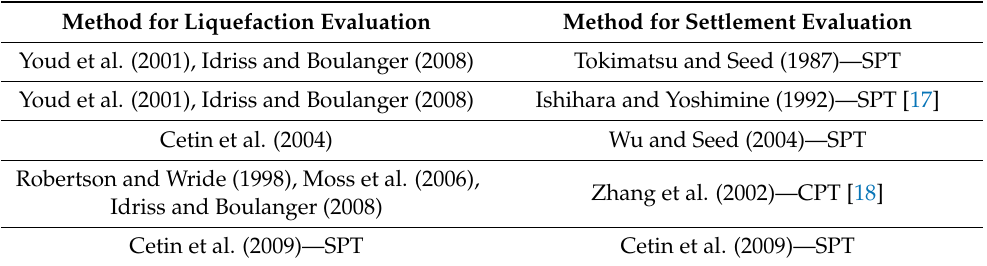
Table 2. Methods applied for the evaluation of the settlement at the free field at the study site. Method for Liquefaction